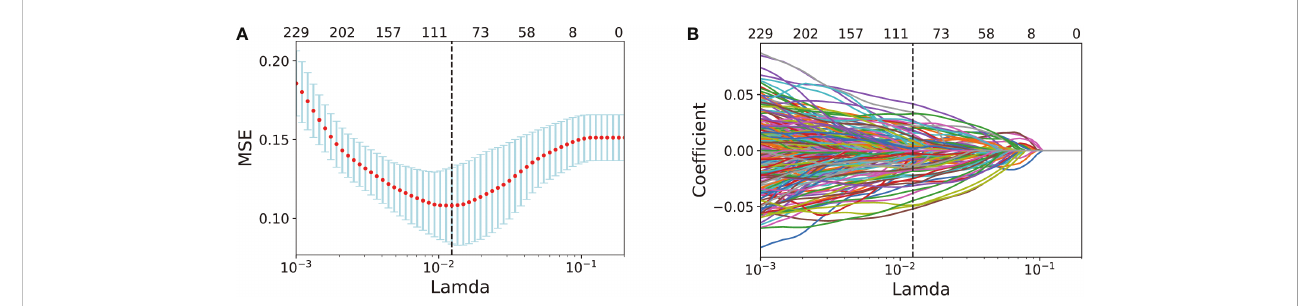
FIGURE 3 AS feature selection performed by LASSO analysis. (A) Selection of the tuning parameter l in the LASSO model via 10-fold cross-validation in the training set. optimal l value of 0.0123, with log ( l )= -4.396, was selected based on minimum criteria. (B) . LASSO coef fi cient pro fi les of the 268 DEAS features. Vertical dot line was drawn at the optimal value where optimal l resulting in 96 nonzero coef fi cients.